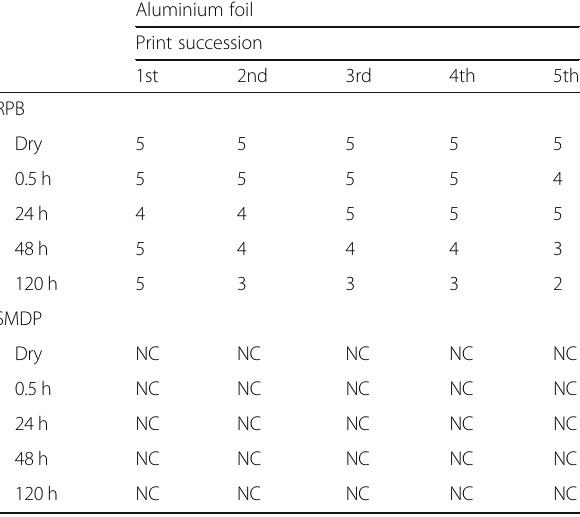
Table 7 Development of submerged and successive prints on aluminium foil using Robin powder blue and Silver magnetic